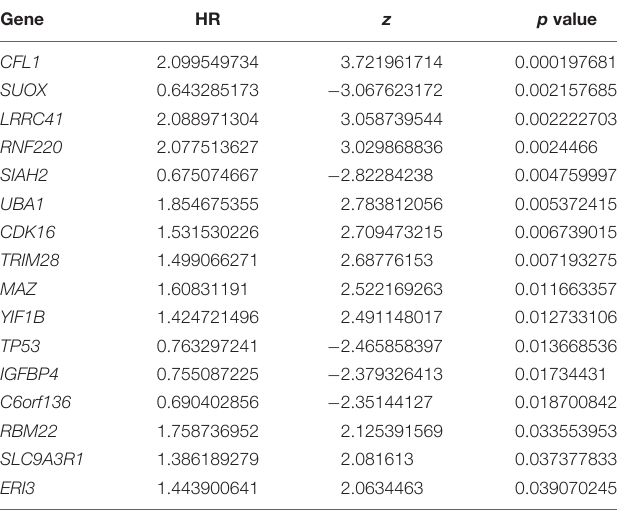
TABLE 2 | The univariate COX analysis of the signature.